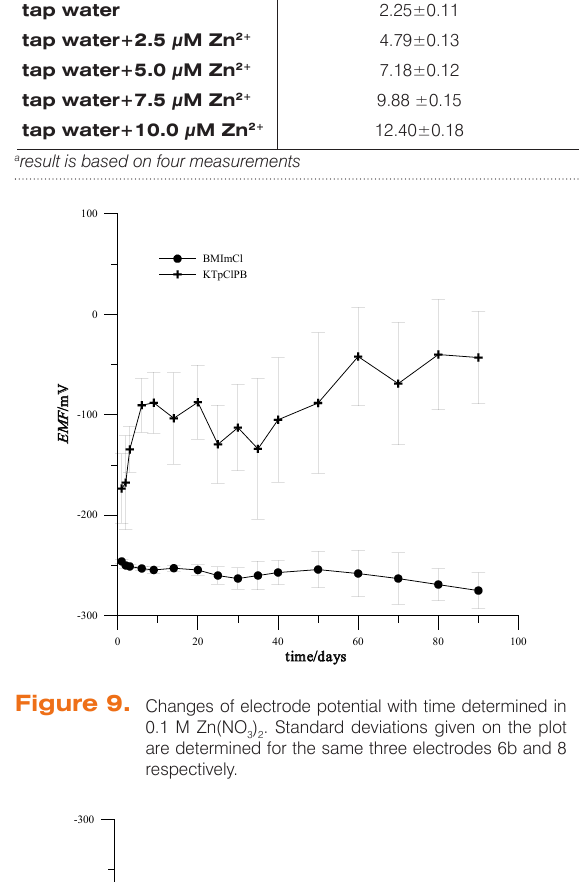
Table 3. Determination of Zn 2+ in tap water by the proposed electrode.